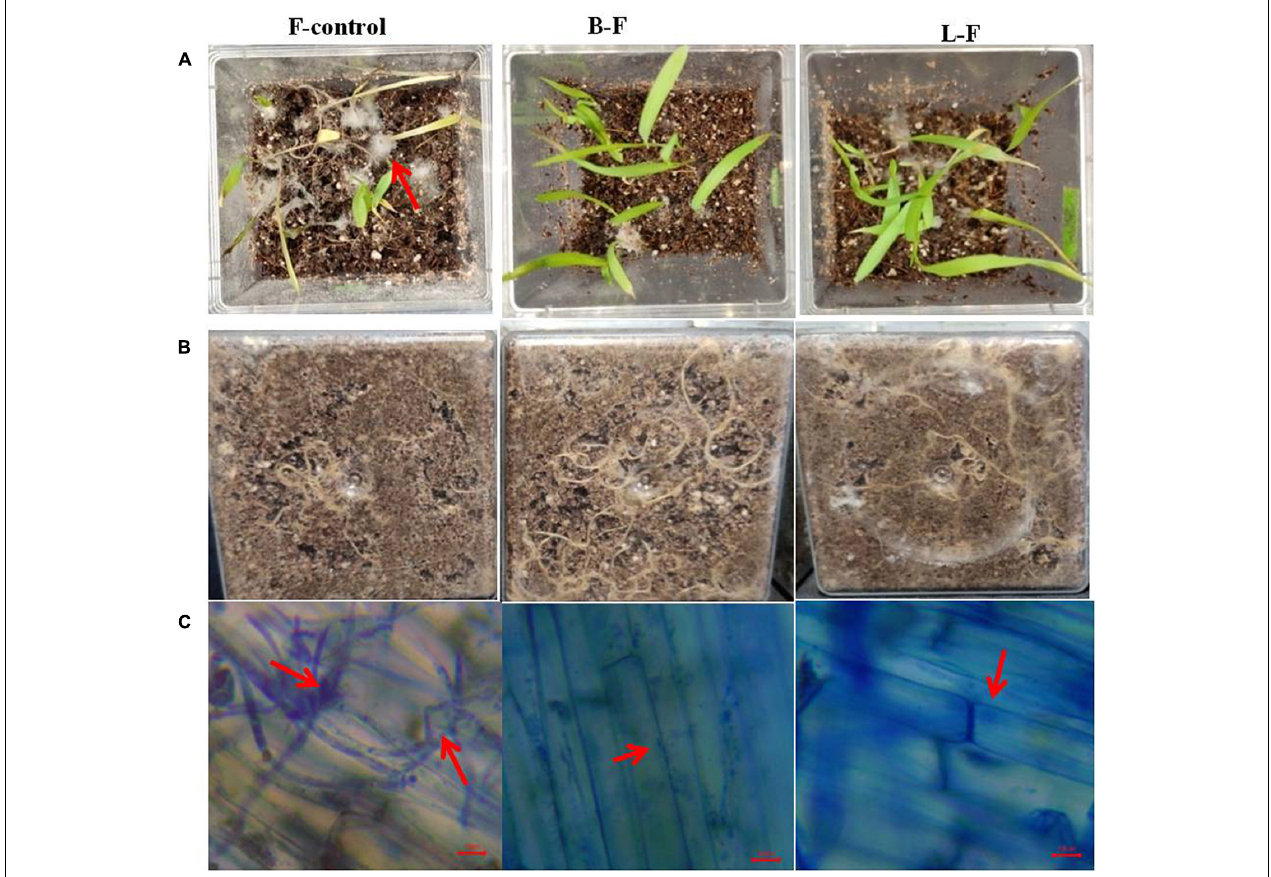
FIGURE 9 | Effect of bacterium and its lipopeptide treatments in protection of seedlings from Fusarium sp. infection inmicrocosm assay in magenta boxes. Where, surface sterilized seeds were inoculated with fungal spores only (column 1: F), Bacillus subtilis and fungal spores (column 2: B-F) and lipopeptide and fungal spores (column 3:L-F). Lane (A) are the images of 8 day old seedlings from the top of the magenta boxes, lane (B) image from the bottom of the same magenta boxes showing root growth, and lane (C) - microscopic images of root surface from all corresponding treatment showing heavy infection of fungal pathogen in control in comparison to treatments